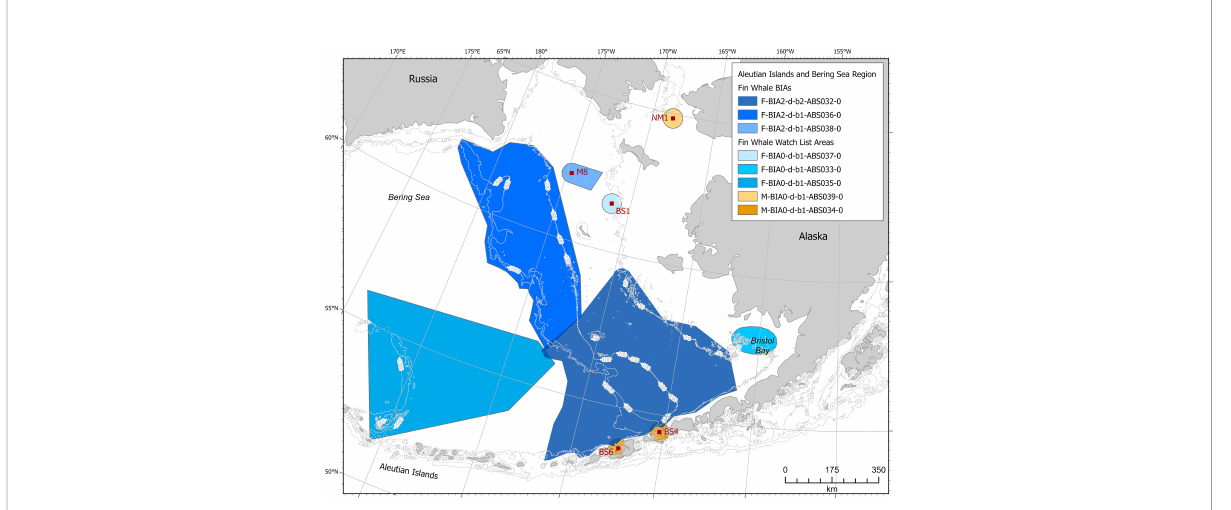
FIGURE 6 Aleutian Islands and Bering Sea region fi n whale BIAs and watch list areas.